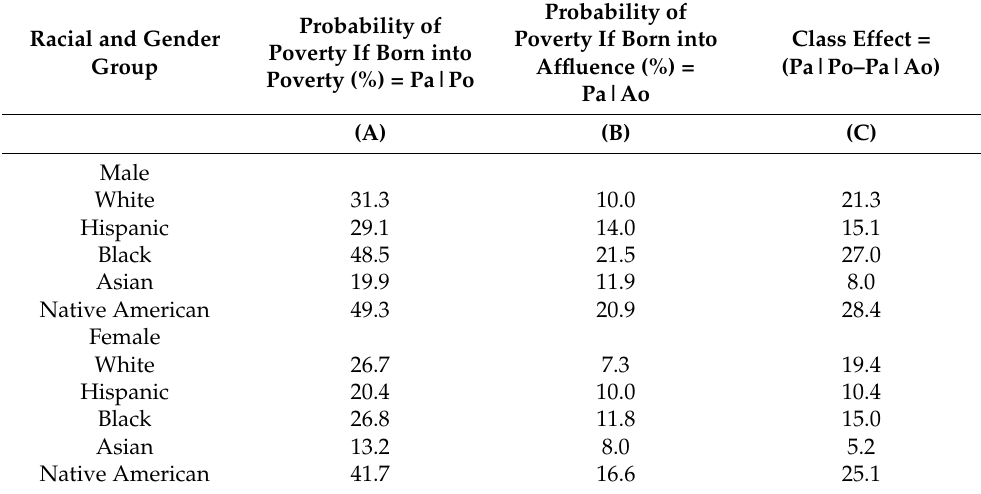
Table 2. Effects of Class Origins by Race and Gender on Becoming a Poor Adult Derived from Results of Chetty et al. (2020).